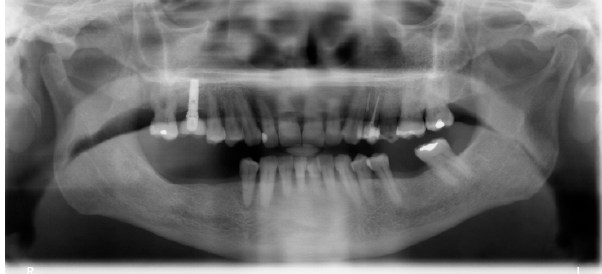
Figure 5. Orthopantomography three years since baseline after extraction of the lower right second premolar, first, and second molars.